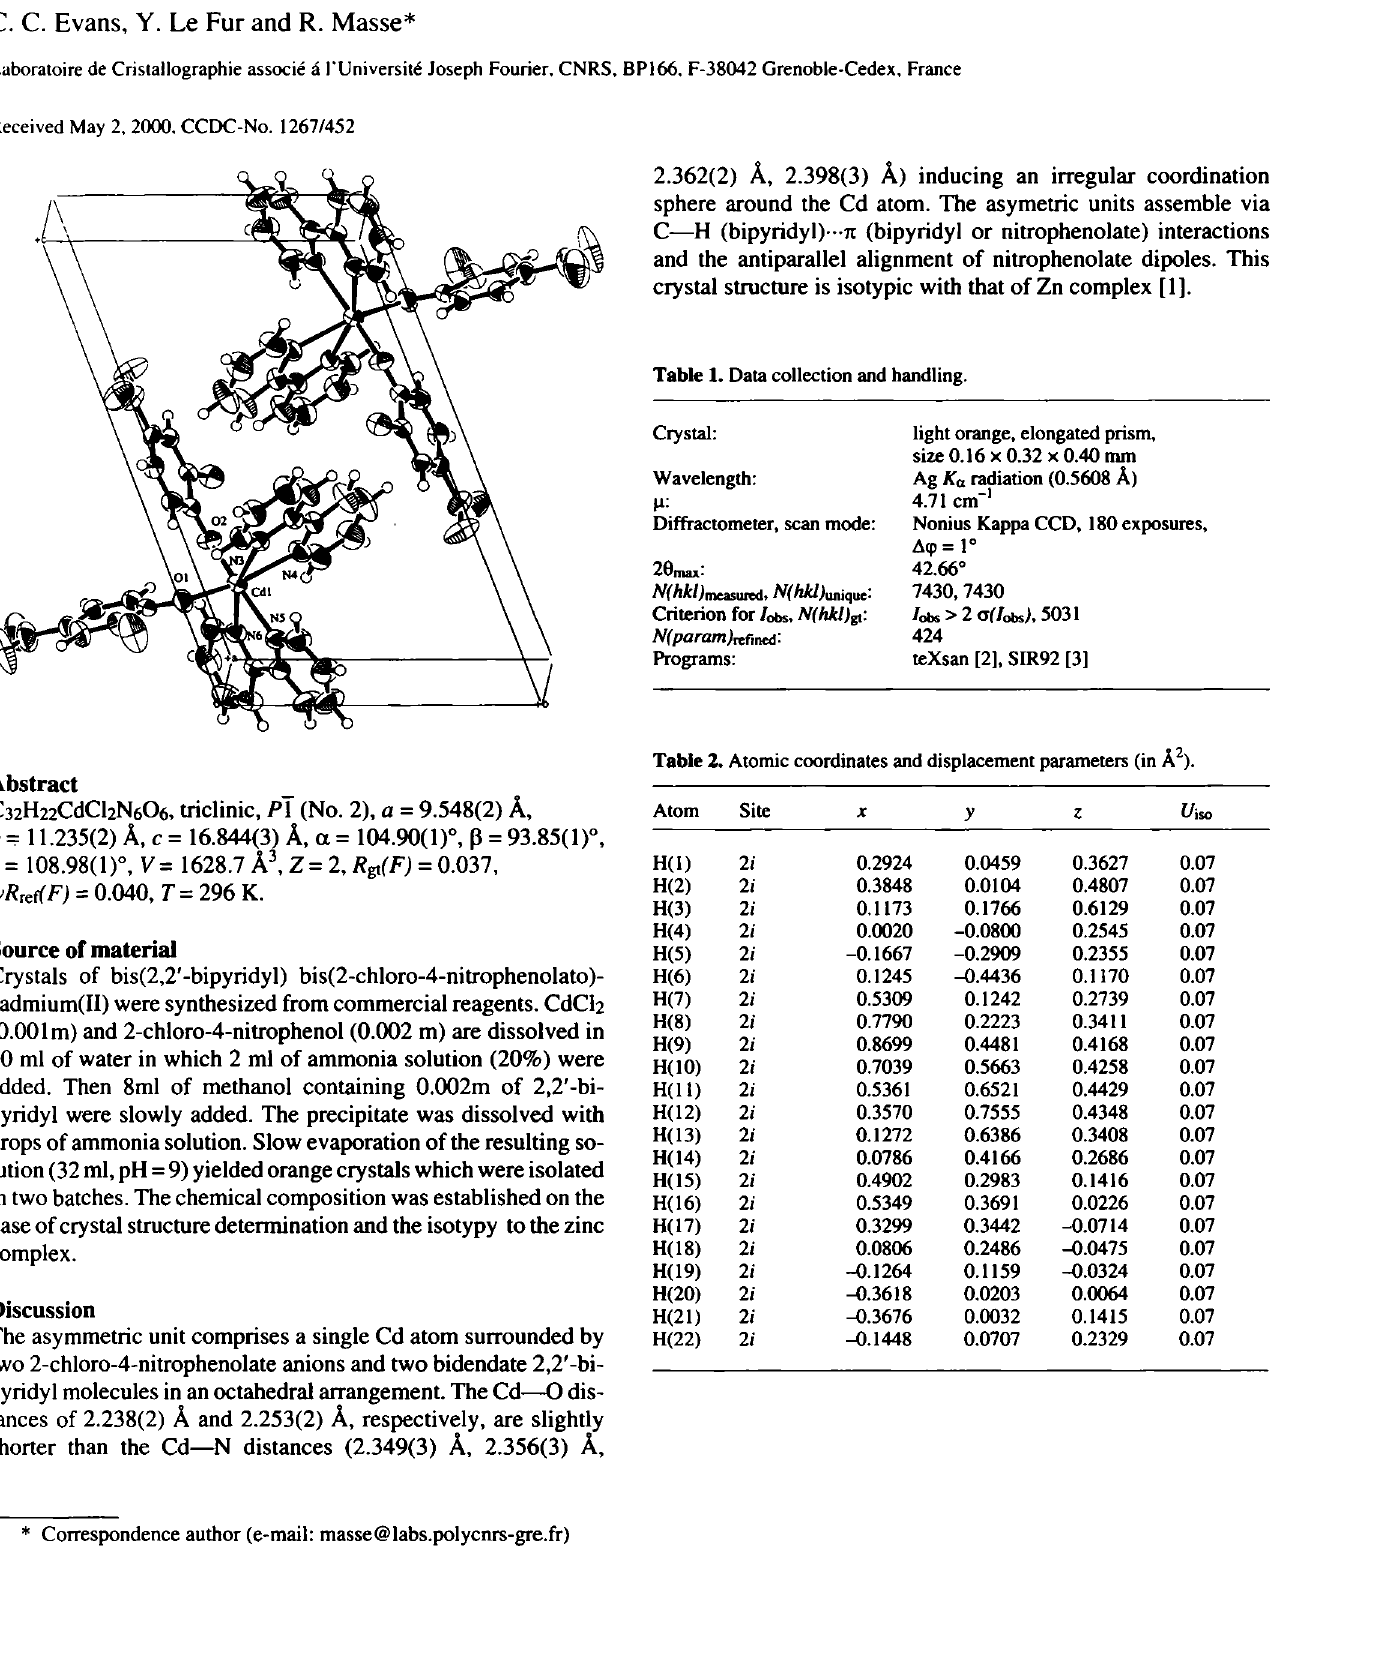
Table 1. Data collection and handling.